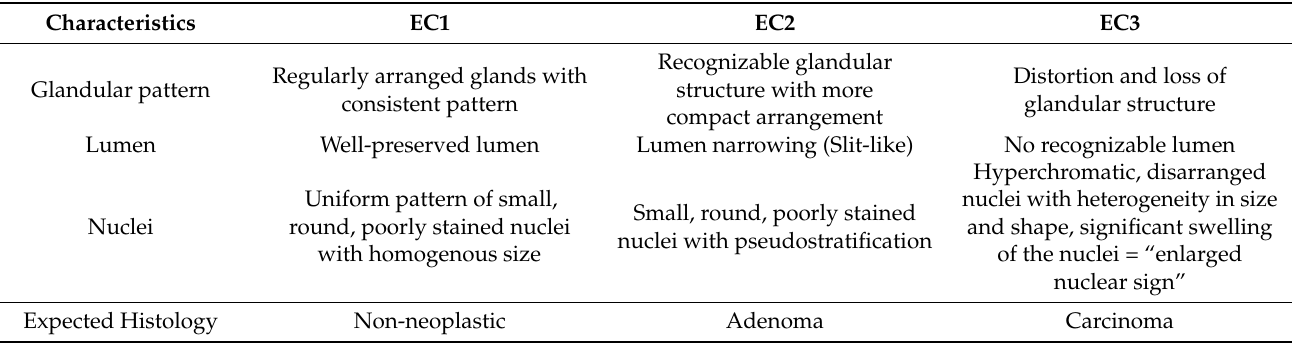
Figure 4. EC Classification: ( A ) EC1 is considered as non-neoplastic, with regularly arranged glands, well-preserved lumen, and poorly stained nuclei; ( B ) EC2 is considered as adenoma, with a more compact glandular arrangement, lumen narrowing and poorly stained nuclei; and ( C ) EC3 is considered as carcinoma with distorted glandular structure and enlarged nuclear sign. The border between the background mucosa and the cancerous area can be noted in this photo. Table 4. Gastric EC